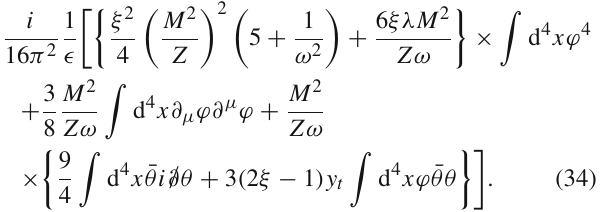
Fig. 3 Various diagrams containing divergences with three vertices. Here the first graph is purely matter oriented and gives correction to Yukawa coupling. The next two diagrams give a correction to ϕ 4 cou-